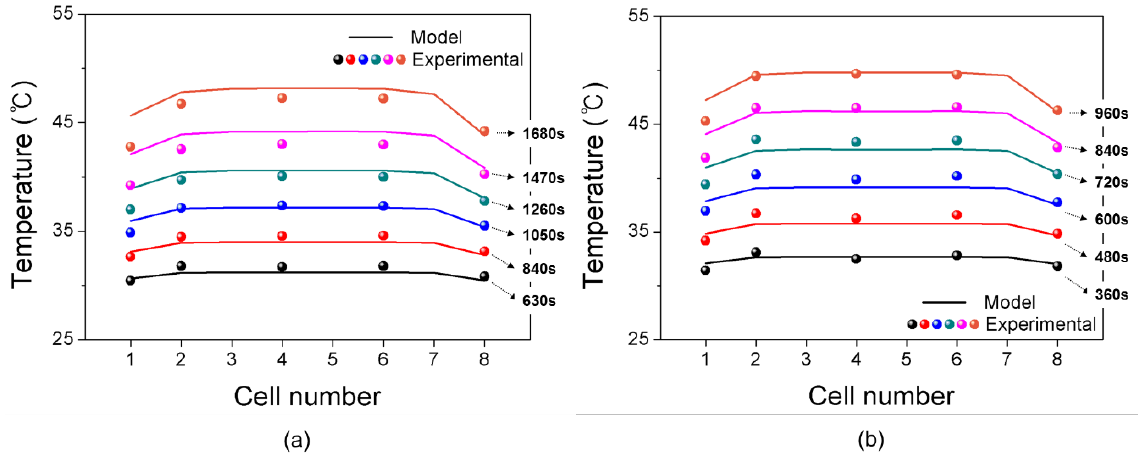
Figure 6. Comparison between the cell temperatures within the module from the experiment and modeling at various discharge times with the discharge rates of ( a ) 2 C and ( b ) 3 C for natural convection cooling.